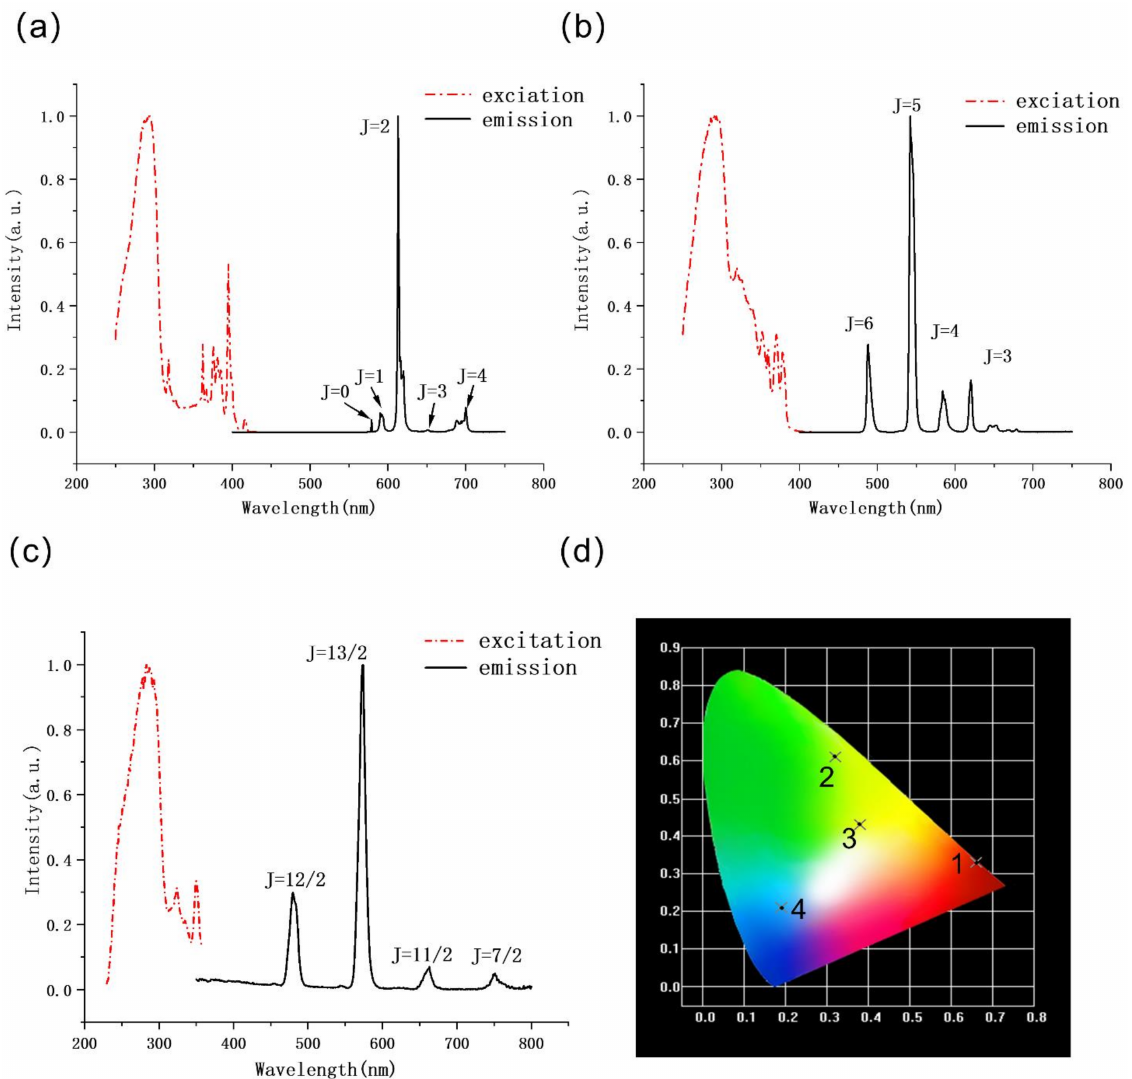
Figure 3. ( a ) The excitation ( λ em = 614 nm) and emission spectra ( λ ex = 297 nm) of 1 . ( b ) The excitation ( λ em = 543 nm) and emission spectra ( λ ex = 299 nm) of compound 2 . ( c ) The excitation ( λ em = 574 nm) and emission spectra ( λ ex = 287 nm) of compound 3 . ( d ) CIE-1931 chromaticity diagram shows the luminescence colors of compounds 1 (0.66, 0.33), 2 (0.32,0.61), 3 (0.38, 0.43), and 4 (0.19,